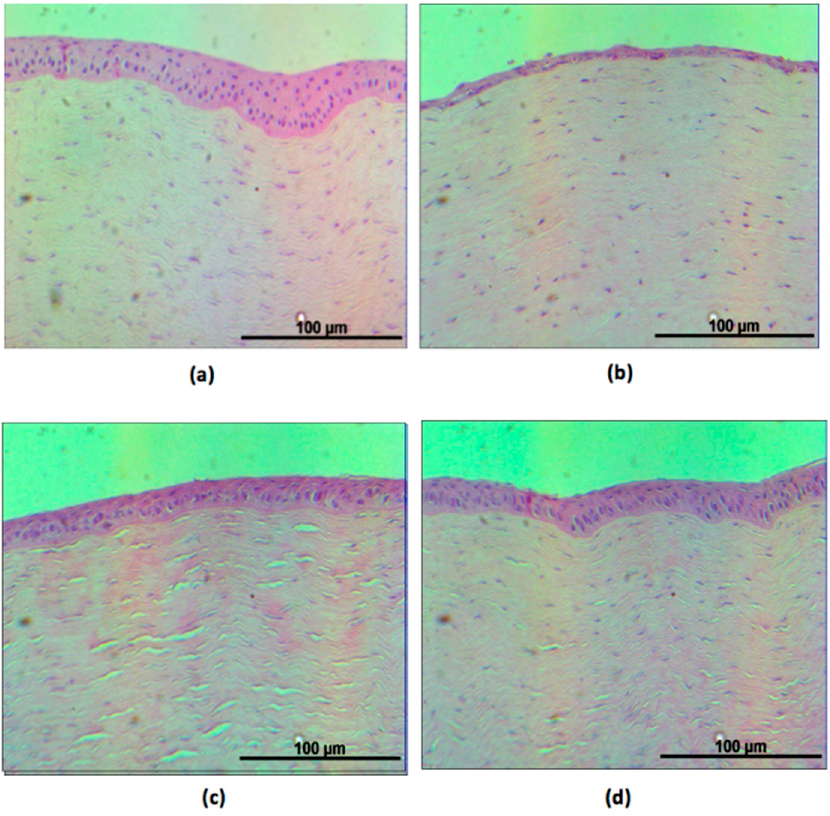
Figure 7. Representative pictures of hematoxylin and eosin (HE)-stained corneal sections from the eyes of rabbits in variant groups. ( a ) Normal cornea, ( b ) 0.1% BAC, ( c ) BS, and ( d ) BS + FA100/KM1.